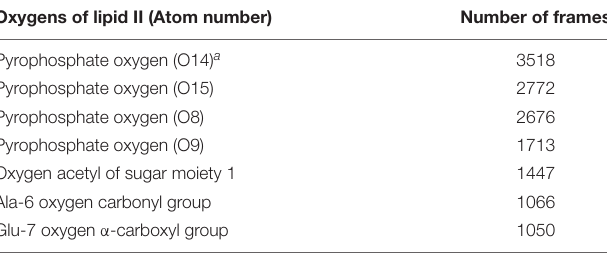
3, 4, and 5 demonstrated bactericidal activities, yielding a